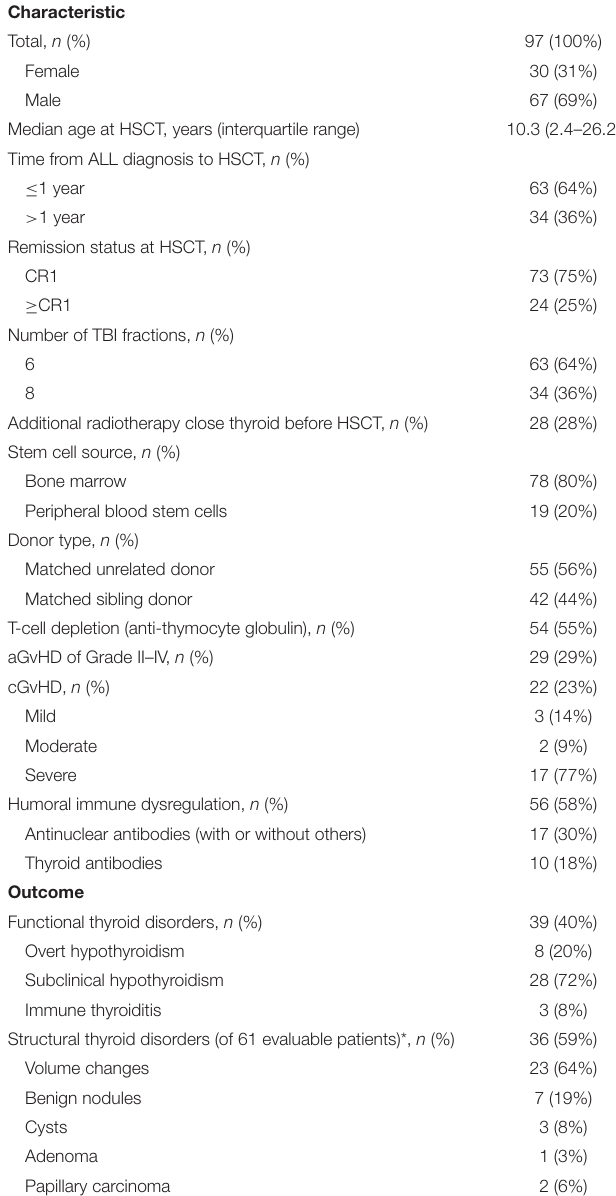
TABLE 1 | Patients’ baseline characteristics, HSCT characteristics and outcomes during follow-up post HSCT.